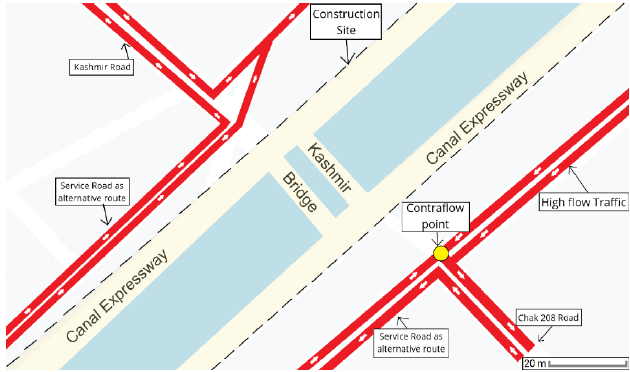
Figure 1: Site map, alternative route for high traffic flow and